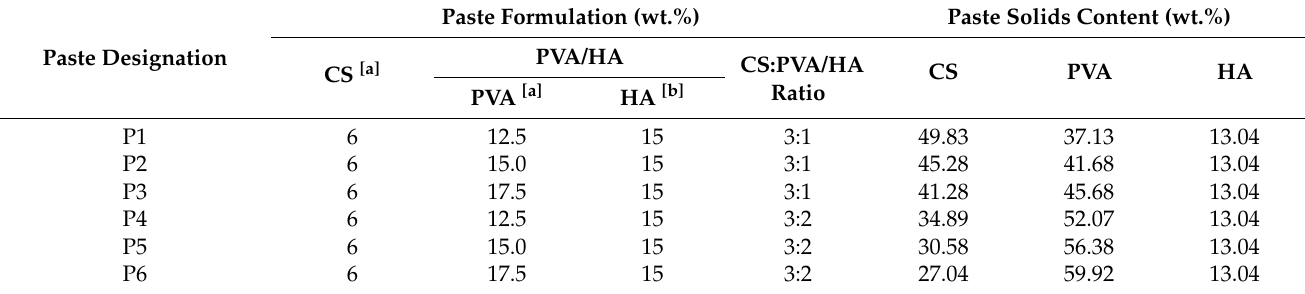
Table 1. Blend at two different ratios of the chitosan solution with three different PVA/HA pastes to attain six paste formulations with varying PVA content and the CS/PVA/HA pastes solid content. Paste Formulation (wt.%) Paste Solids Content (wt.%) Paste Designation